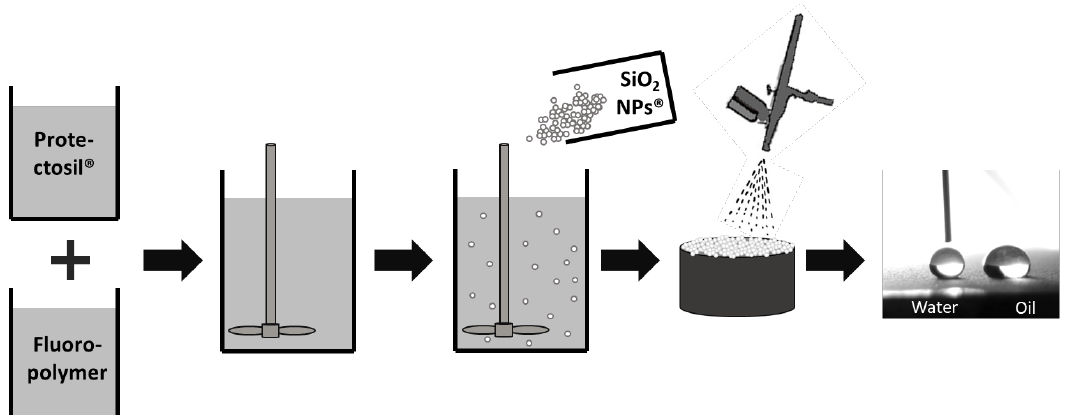
Figure 1. Schematic presentation of the method which was applied to produce superamphiphobic coatings on marble.